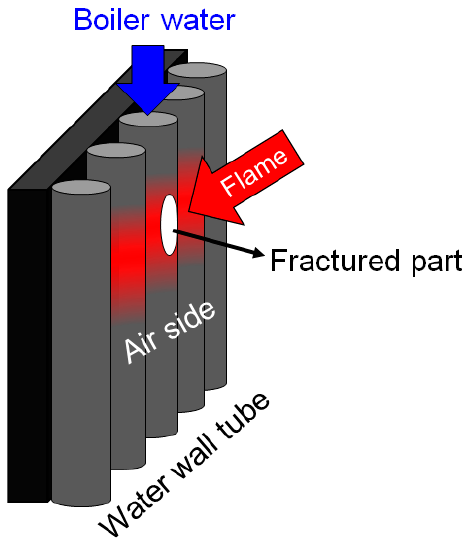
Figure 1. Schematic of a boiler water wall tube and the operating environment.